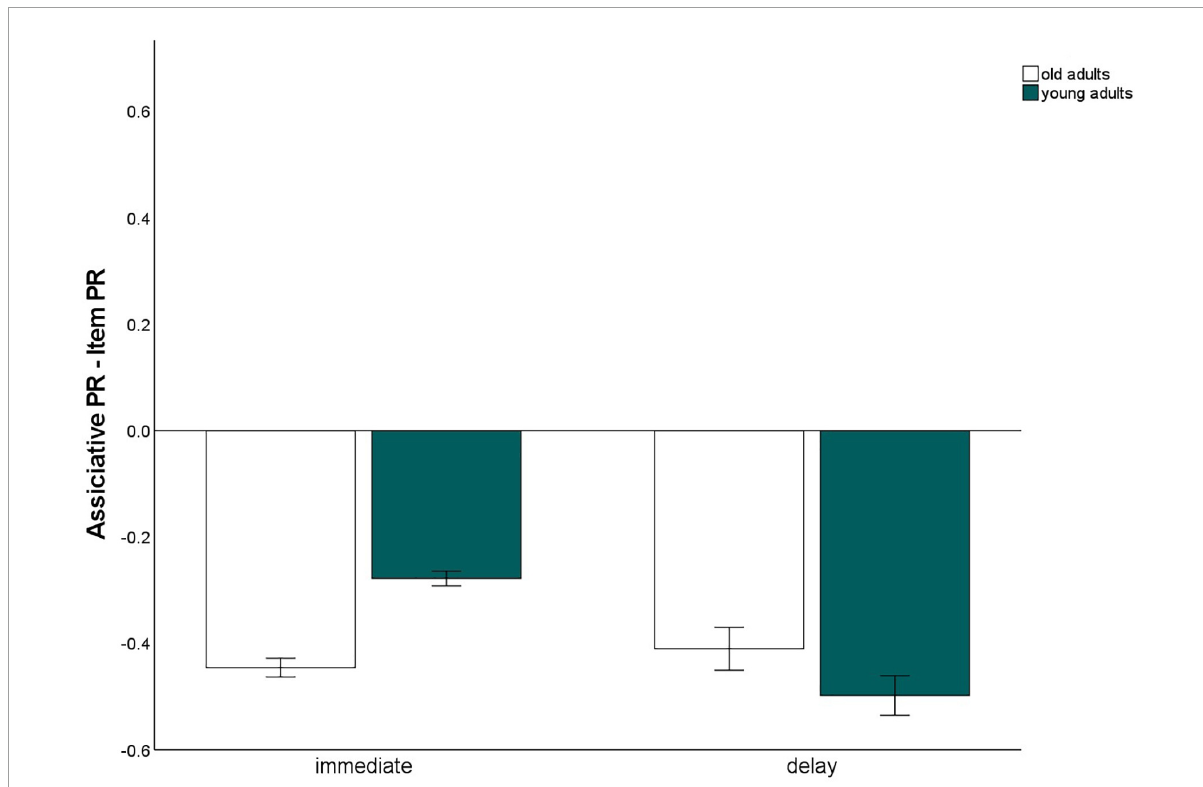
FIGURE7 Associative recognition PR, relative to item recognition PR, averaged over material types within immediate and delayed retrieval. Error bars represents the standard of the error